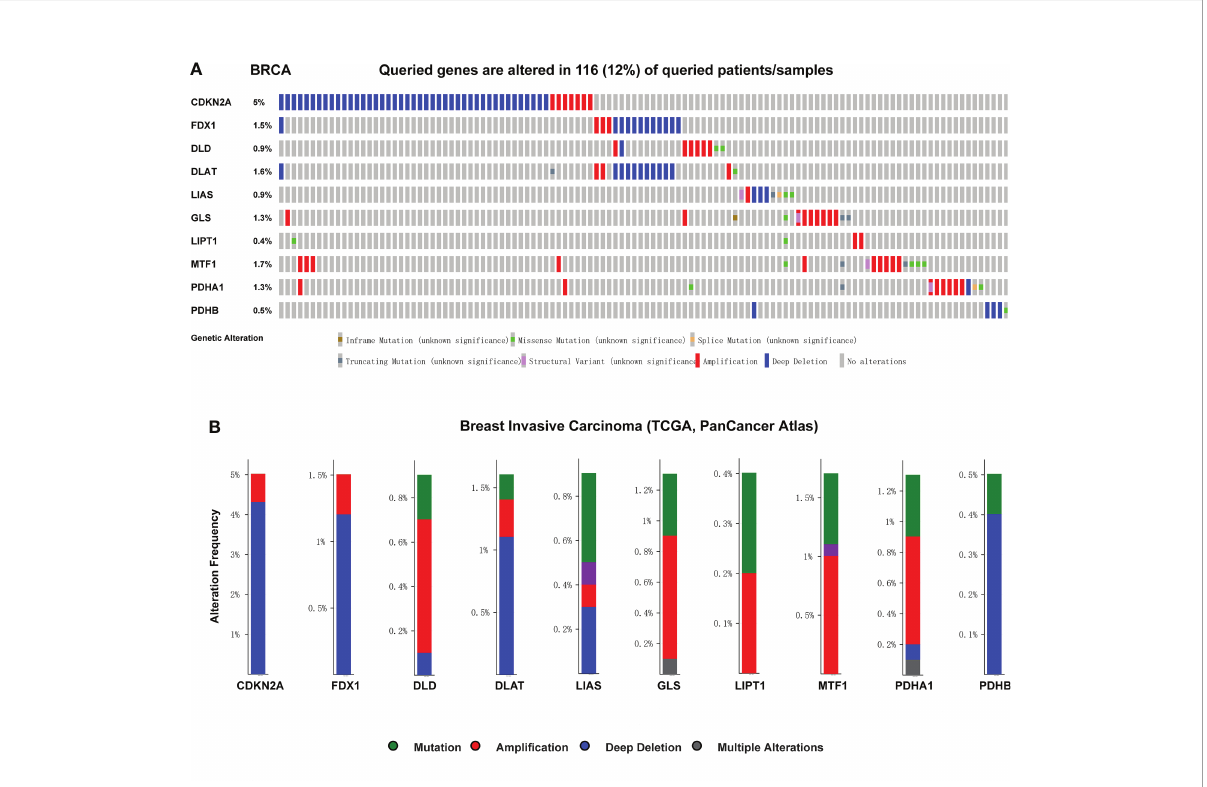
FIGURE 7 Genetic mutation and correlation analysis of CRGs in BC. (A) Pro fi le of alteration rates for CRGs in BC using cBioPortal (B) Genetic alteration frequency data of CRGs in BC using